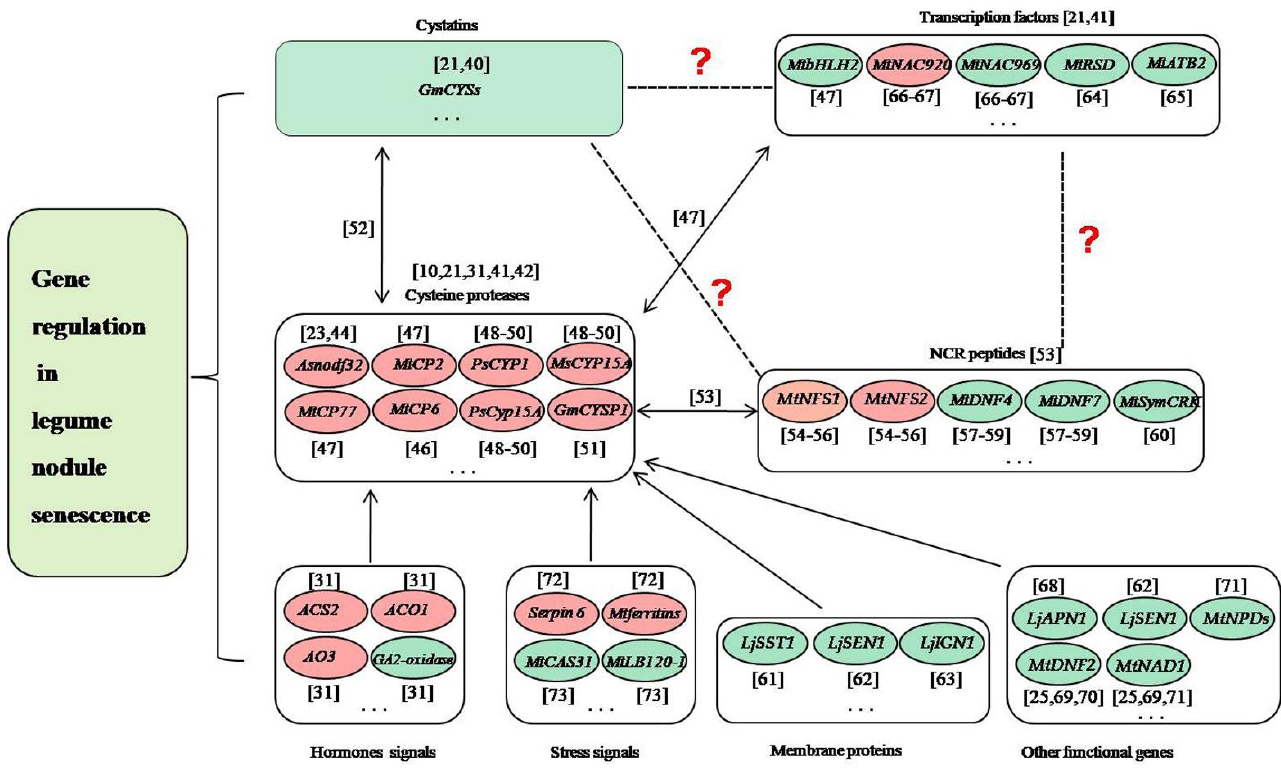
Figure 1. Prediction of the relationships among cysteine proteases, cystatins, NCR proteins, transcription factors and other genes in the regulation of nodule senescence. The dotted lines and/or question marks indicate that the relationship between the two proteins is uncertain. The double arrows indicate that the direct regulatory relationship between the two proteins is proved. The single arrows indicate that the relationship between the two proteins exists. The red ellipses indicate that the genes positively regulate nodule senescence. The green ellipses indicate that the genes negatively regulate nodule senescence. The ellipsis indicates that many genes have not yet been identified.